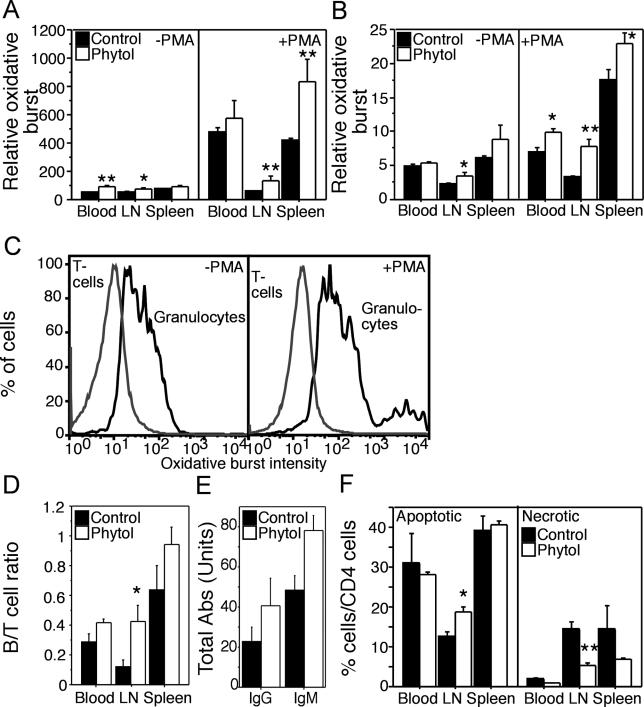
Increased Levels of ROS Alter Cell Distributions(A) The phytol-induced increase in oxidative burst in granulocytes is not organ specific. Granulocytes taken from blood, LNs, and spleen on day 5 after phytol injection were analyzed for oxidative burst with and without PMA stimulation (n = 5).(B) Phytol increases oxidative burst in T cells with or without PMA stimulation 5 d after injection (n = 5). (A) and (B) are taken from different experiments and levels should thus not be compared.(C) ROS production in T cells is low compared to that in granulocytes. ROS production with and without PMA stimulation in spleen granulocytes and T cells from a naïve DA.Ncf1
DA rat.(D) Cell distribution is altered after phytol. Cell distribution in different organs analyzed 5 d after phytol by staining for B and T cells (n = 5).(E) The phytol effect is not mediated by a general immune-suppressive effect. Total levels of IgG and IgM antibodies in plasma measured 5 d after phytol injection expressed as relative values (n = 5).(F) Phytol does not increase cell death. Percentage of apoptotic (Annexin V+ and PI−) and necrotic (Annexin V+ and PI+) CD4+ cells ex vivo 5 d after phytol injection (n = 5).*p < 0.05, **p < 0.01.